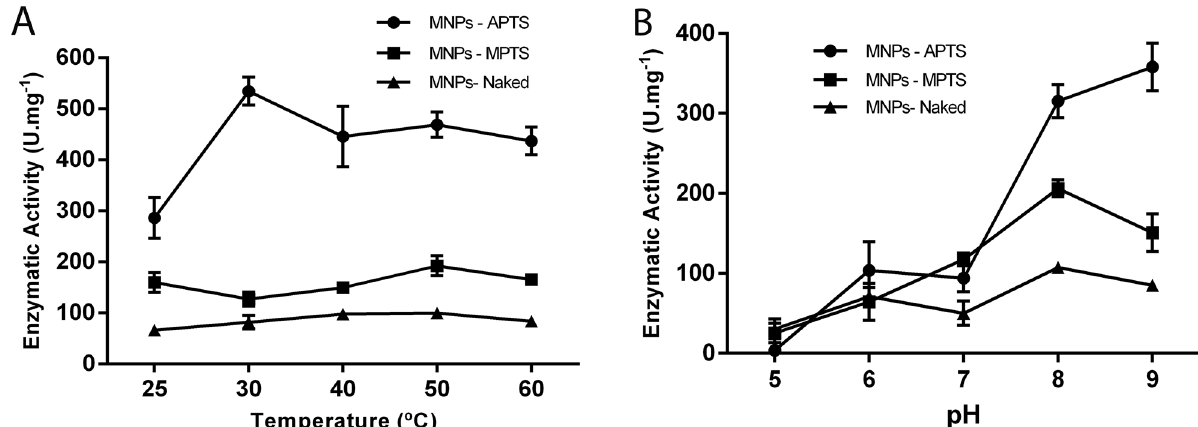
Figure 7. Evaluation of the stability of lipases immobilized by different conjugation strategies. Effect of temperature ( A ) and effect of pH ( B